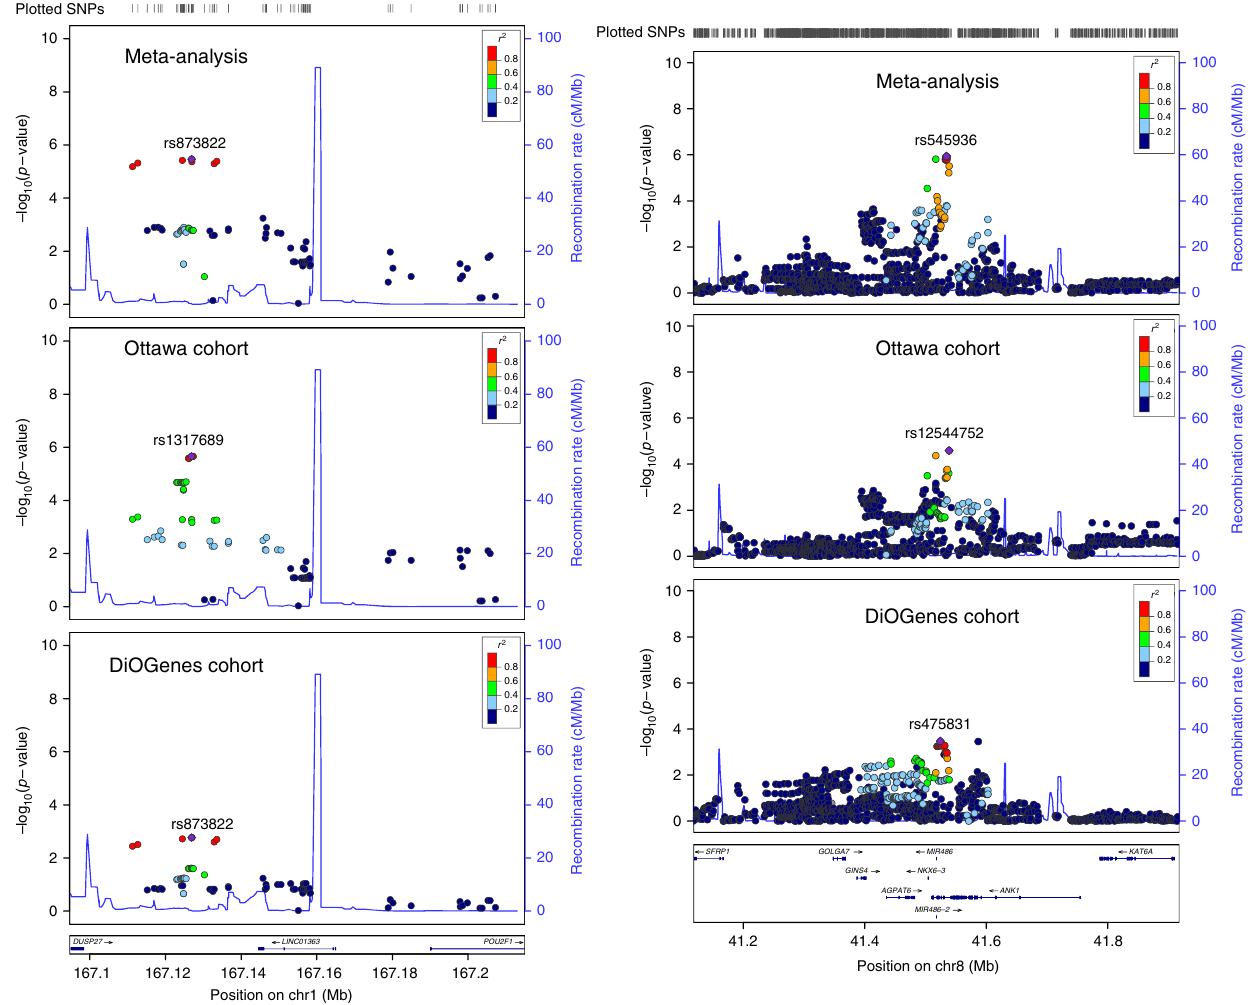
Fig. 2 LocusZoom plots for the RBSG4 (LINC01363) and the MIR486/NKX6.3 loci. Left (right) panel corresponds to RBSG4 (MIR486/NKX6.3/ANK1). Panels from top to bottom correspond to results from the meta-analysis, the Optifast900 cohort and the DiOGenes cohort. Source data are provided as a Source Data fi